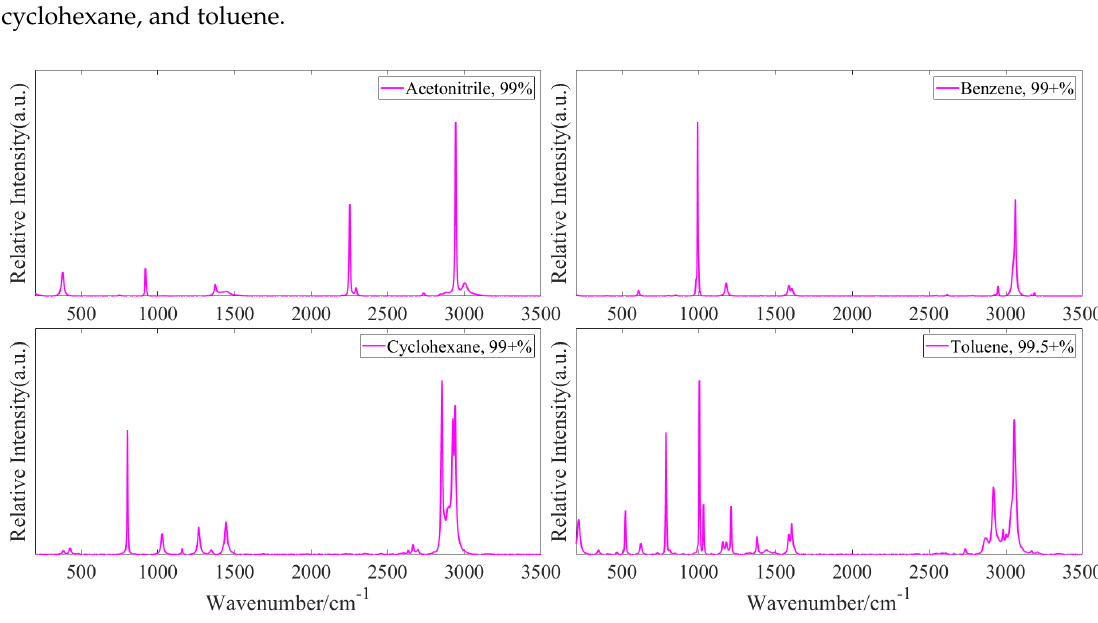
Figure 3. Four examples from experimental Raman